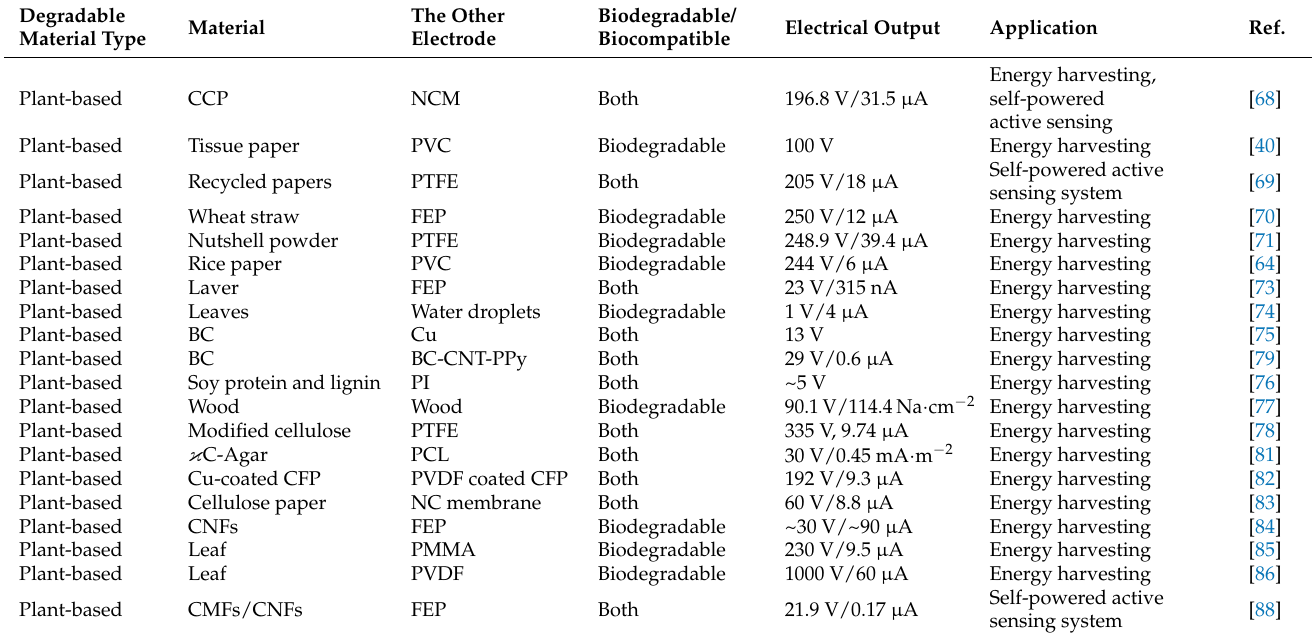
Table 1. Performance comparison of BD-TENGs with different triboelectric